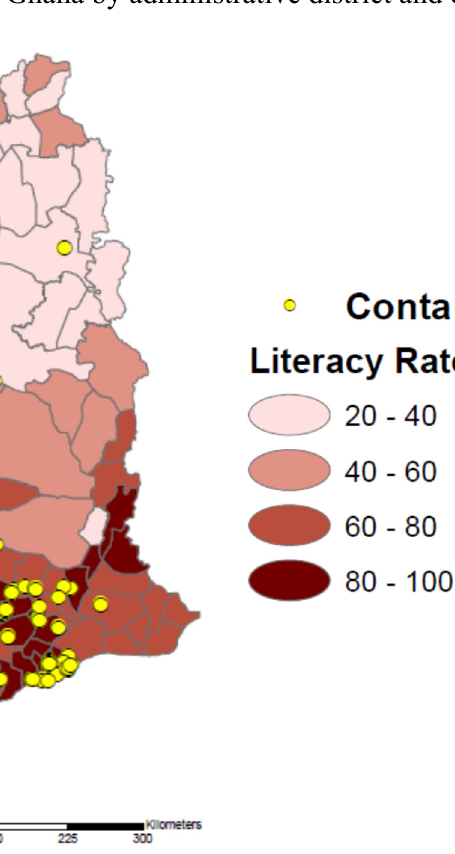
Figure 5. Education in Ghana by administrative district and contaminated sites.